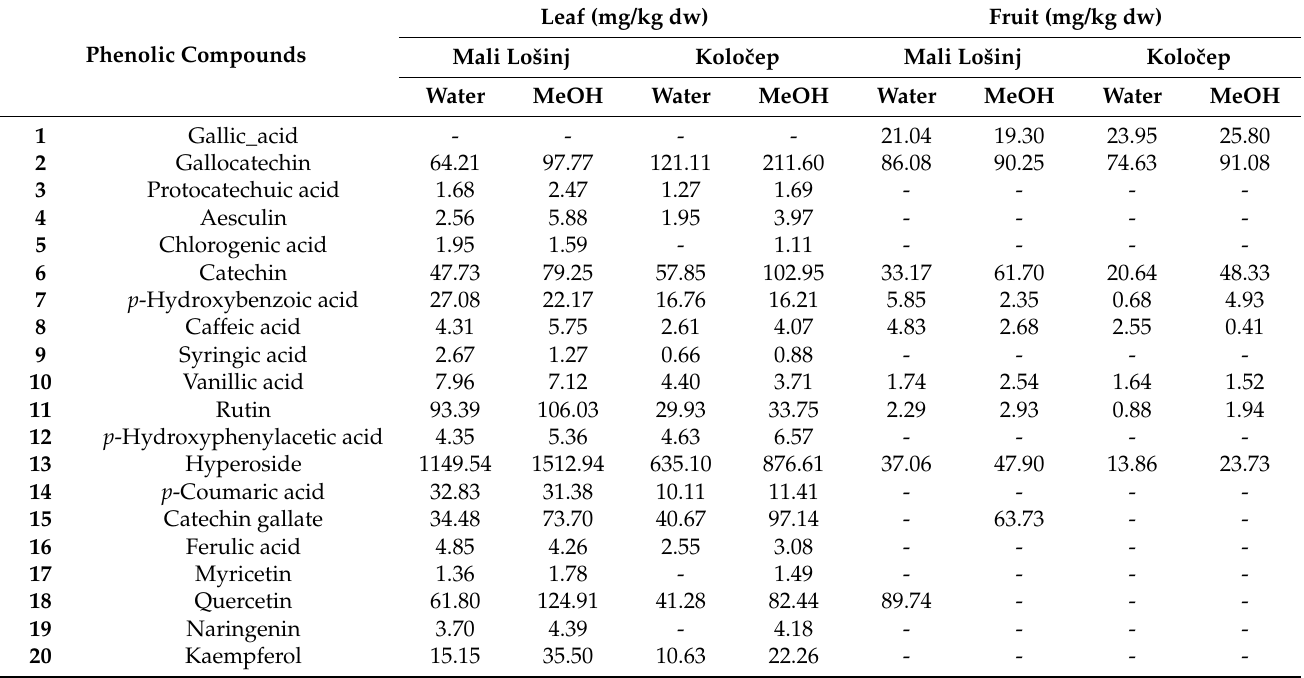
Table 2. Quantification of some phenolic compounds in strawberry tree ( Arbutus unedo L., Ericaceae) leaves and